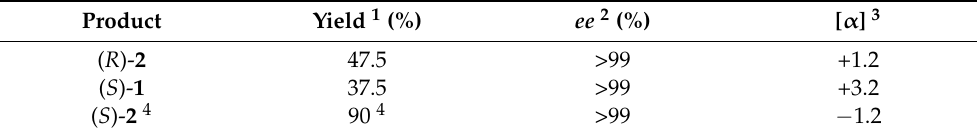
Table 1. Kinetic resolution of racemic 4-(morpholin-4-yl)butan-2-ol ( ± )- 1 with CaLB-MNP C15 in batch